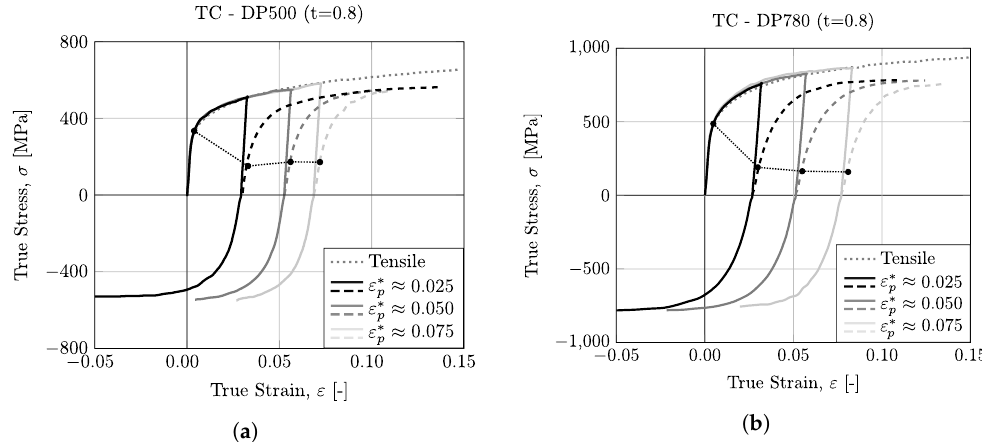
Figure 10. True Stress–Strain curves from tension–compression tests for ( a ) DP500 and ( b ) DP780.